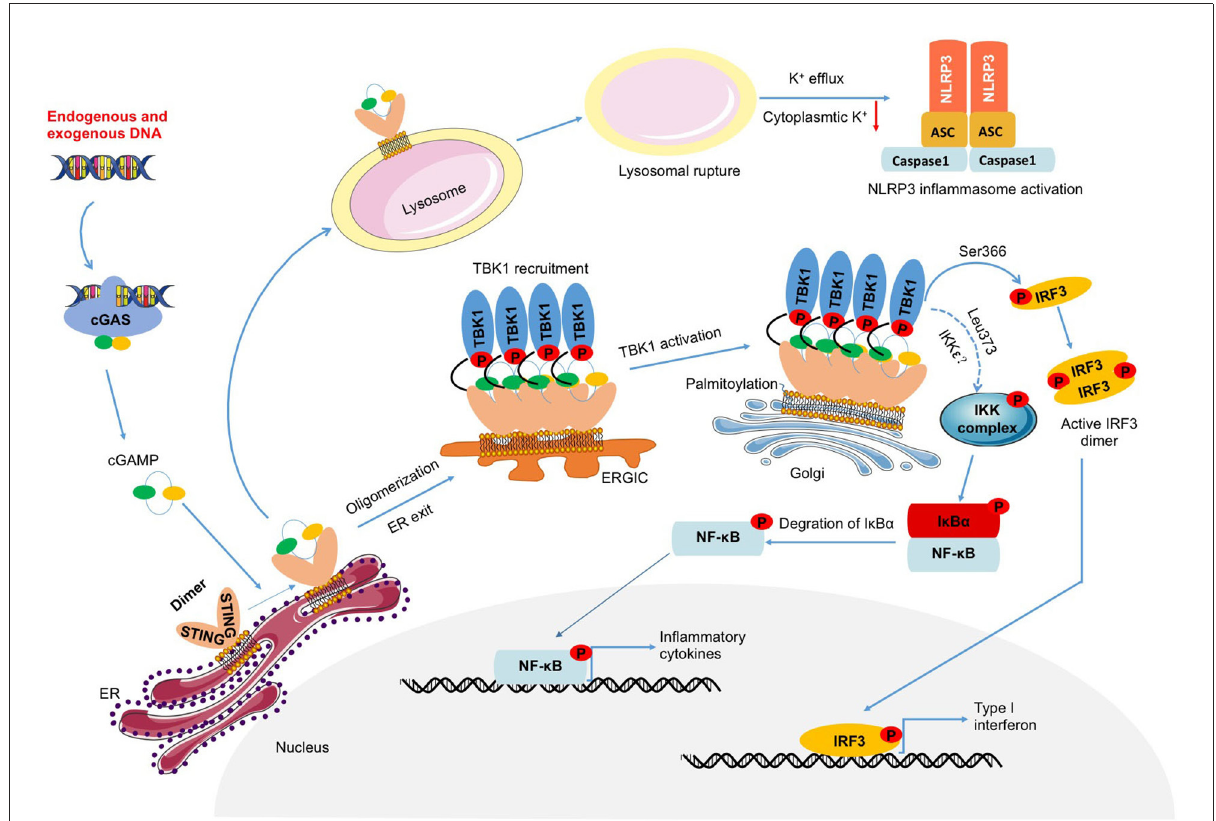
FIGURE1 DNA-cGAS-STING-mediated inflammation. Endogenous or exogenous DNA leads to cGAS activation, which catalyzes the production of cGAMP. Activated STING induced by cGAMP not only triggers the activation of TBK1-IRF3 and NF- κ B which induce the transcription of IFNs and inflammatory factors, but also prompts NLRP3 inflammasome activation through lysosomal rupture-induced K +